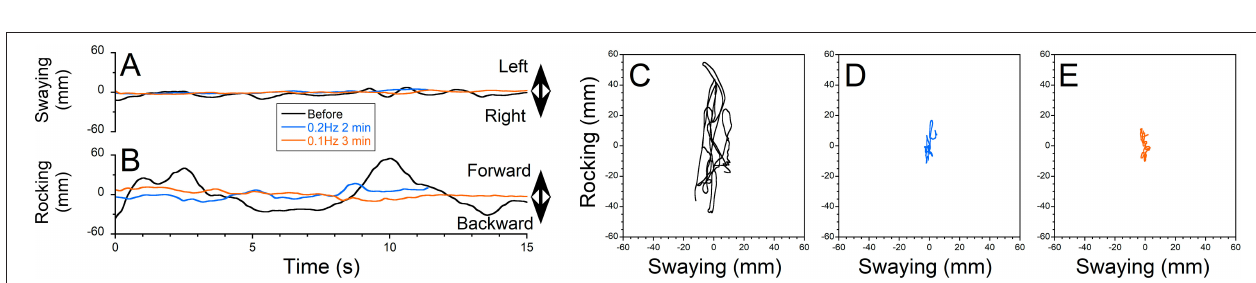
FIGURE 3 | The treatment of gravitational pull-back sensations. Patient VRG017 had experienced gravitational pull back. (A) Swaying and (B) rocking during treatment. Resistance to pull back on the trace looks like body rocking at 0.2 Hz with constant body drift backward. (C–E) X-Y plot of posture obtained prior to treatment (C) , after two treatments with upward OKN for 4 min (D) and 5 min (E) , respectively.